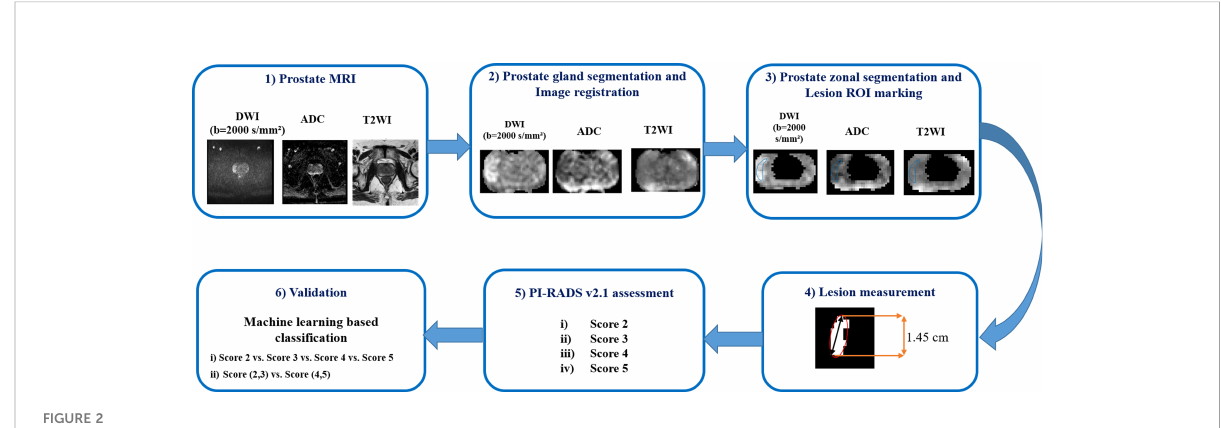
FIGURE 2 Proposed work fl ow of the semi-automated model for PI-RARS v2.1